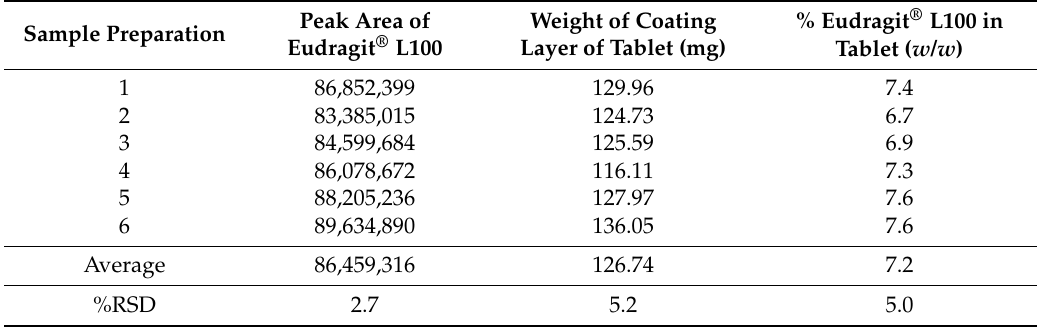
Table 3. Precision of Eudragit ® L100 in analysis of local market samples of enteric-coated tablet. Sample